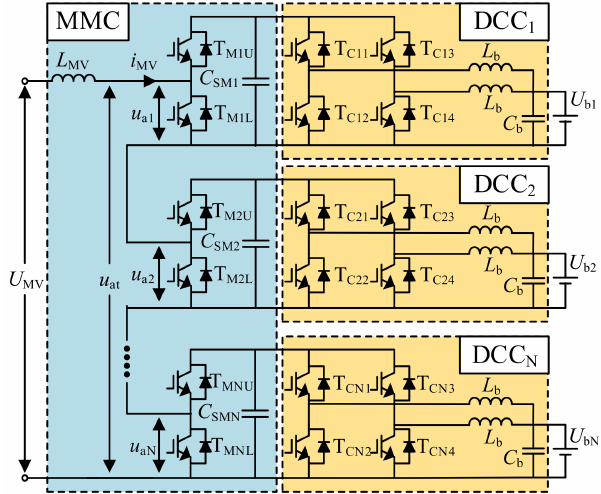
Figure 1. Topology of